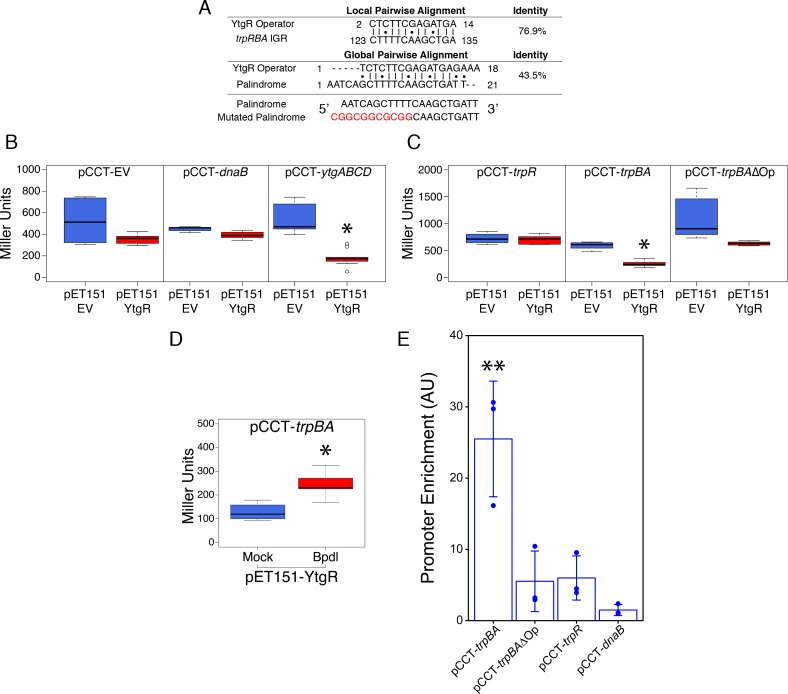
Ectopically expressed YtgR is binds the putative trpBA promoter element in an operator-specific manner to repress transcription in a heterologous in vivo system.(A) Identification of putative YtgR operator sequence by local and global nucleotide sequence alignment using EMBOSS Water and Needle algorithms, respectively, to align the previously identified YtgR operator to both the trpRBA IGR and palindromic candidate sequence. The palindrome was then mutated in our YtgR repression assay as depicted to abolish palindromicity and AT-richness. (B) Ectopic expression of YtgR significantly represses β-galactosidase activity only from the promoter of its own operon, ytgABCD, and not from an empty vector or the non-iron-regulated promoter of dnaB. N = 3. (C) Expression of recombinant YtgR represses β-galactosidase activity from the putative trpBA promoter element, but not the trpR promoter, and this repression is dependent on the unaltered operator sequence identified in Figure 5A. (D) Bipyridyl-treatment reduces YtgR repressor activity at the trpBA promoter element, consistent with the iron-dependent DNA-binding of YtgR. (E) Immunoprecipitation of YtgR reveals specific and direct interaction with the trpBA promoter that is dependent upon the native operator sequence. N = 3. For the Miller assay, statistical significance was determined by two-sided unpaired Student’s t-test with Welch’s correction for unequal variance. For the ChIP assay, statistical significance was determined by One-Way ANOVA and post-hoc pairwise t-test with Bonferroni’s correction for multiple comparisons. *=p < 0.05, **=p < 0.01, ***=p < 0.005.
10.7554/eLife.42295.017Figure 5—source data 1.Source data for Figure 5B–E.